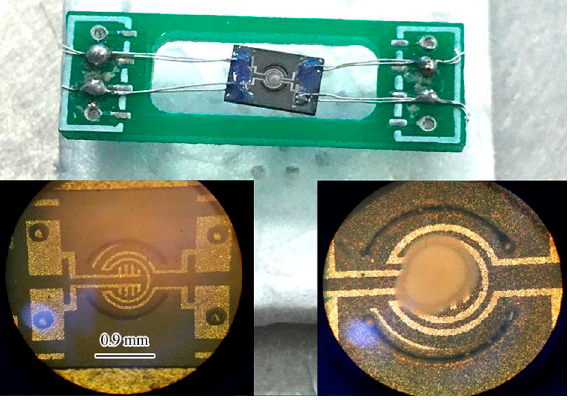
Figure 6. The real photograph of the sensor sealing structure.